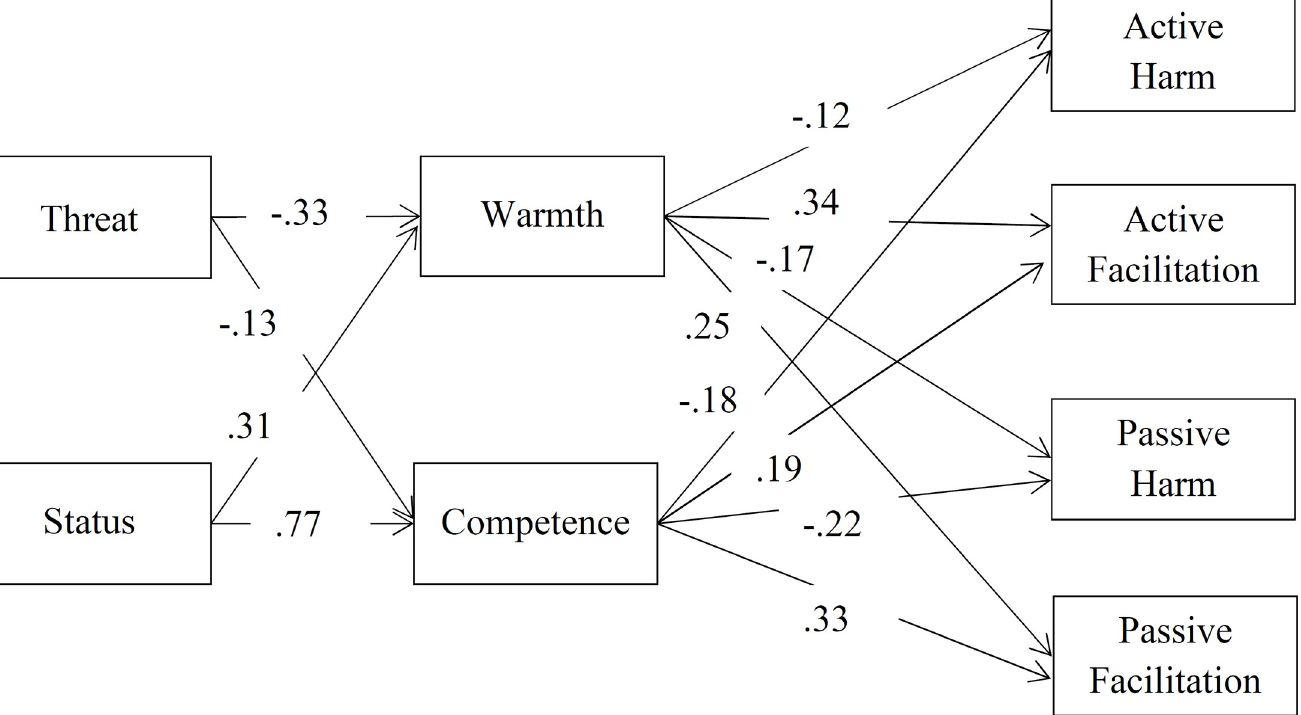
Fig 2. Results of modified path